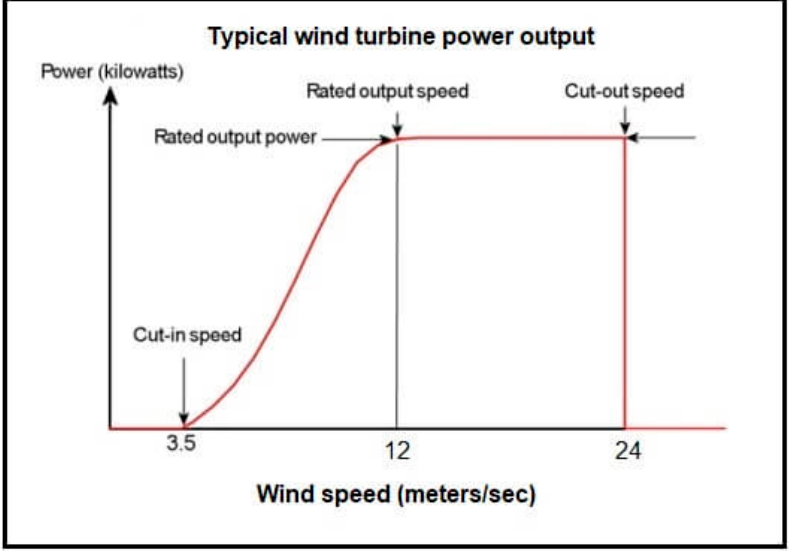
Figure 5. Electricity production based on wind speed. Source: Wind Power Engineering [65].